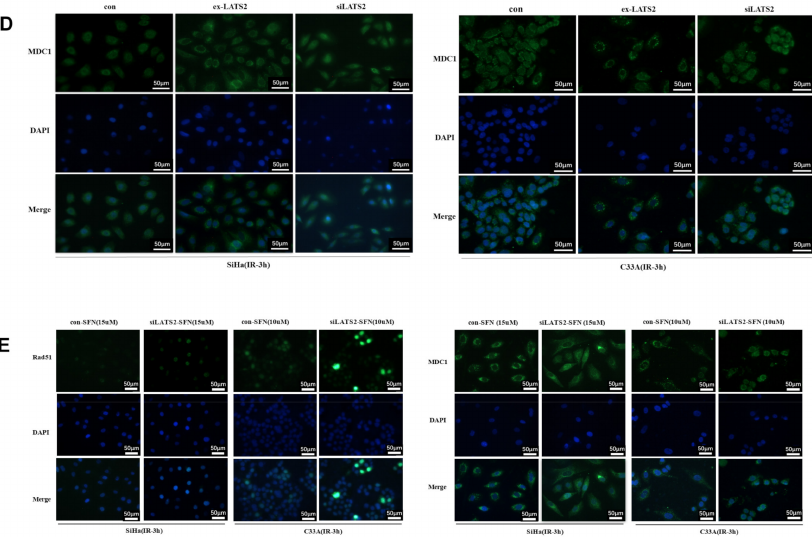
Figure 4. Effect of LATS2 on DSB response. ( A ) Colony formation after irradiation in SiHa and C33A cells with LATS2 overexpression and LATS2 knockdown. Colonies of >50 cells were produced after 2 weeks of incubation. ( B ) Immunofluorescence analysis of DNA damage according to the presence of γ H2AX in SiHa and C33A cells with LATS2 overexpression or control, and Western blotting was conducted to quantify γ -H2AX protein levels 3 h after being subjected to IR. Cropped blots were shown in Western blotting. The samples derived from the same experiment and those blots were processed in parallel. ( C , D ) Representative immunofluorescence images of Rad51 and MDC1 nucleus foci formation 3 h after irradiation in cells with LATS2 overexpression and LATS2 knockdown. ( E ) Representative immunofluorescence image of Rad51 and MDC1 nucleus foci formation 3 h after irradiation in SiHa and C33A cells of LATS2 knockdown and SFN treatment, compared with SFN treatment. ** p < 0.01, *** p <